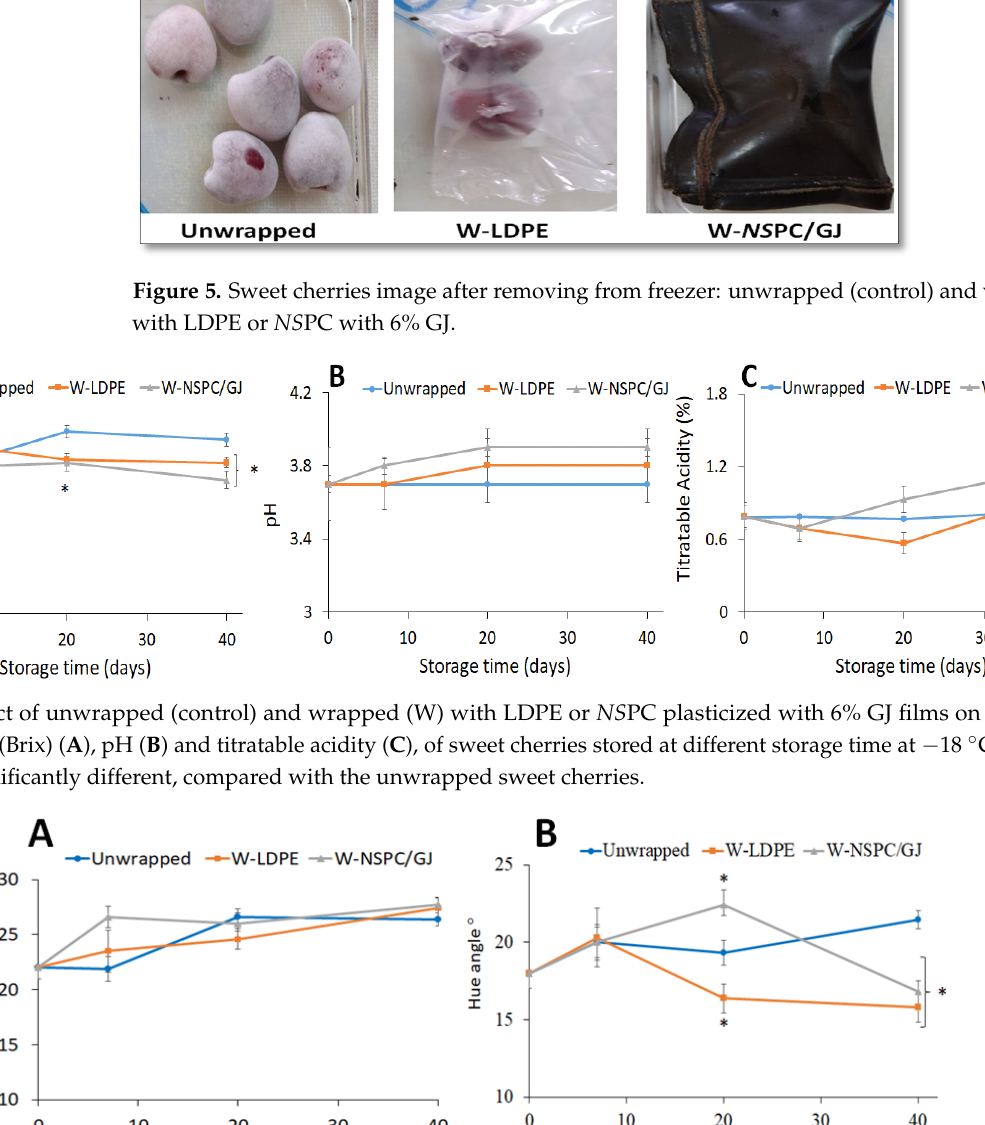
Figure 6. Effect of unwrapped (control) and wrapped (W) with LDPE or NS PC plasticized with 6% GJ films on soluble solids content (Brix) ( A ), pH ( B ) and titratable acidity ( C ), of sweet cherries stored at di ff erent storage time at − 18 °C. Value with (*) is significantly different, compared with the unwrapped sweet cherries. Figure 7. The effects of unwrapped and wrapped (w) with LDPH and NS PC plasticized with 6% GJ on optical properties of sweet cherries stored at di ff erent storage times at − 18 °C. Value with (*) is significantly different compared with the unwrapped sweet cherries. ( A ) L* ; ( B ) Hue angle.